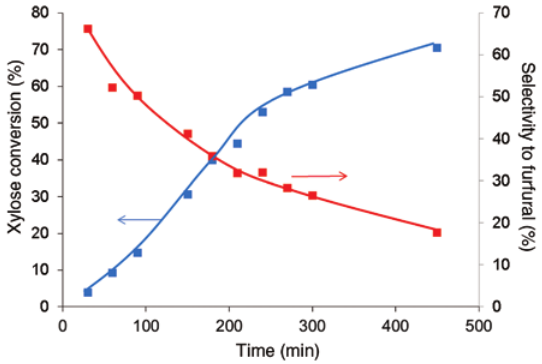
Figure 3: Time dependence of xylose conversion and furfural selec- tivity during xylose dehydration in aqueous phase (165 ° C, xylose 10 g, water 300 ml, Amberlyst-15 10 g).